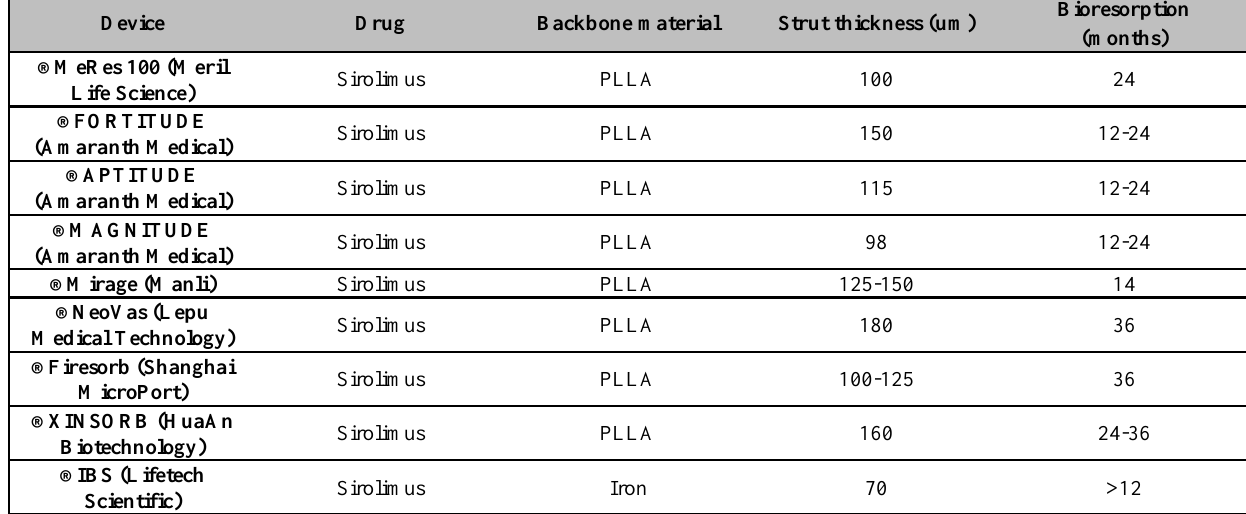
Table 3: Design characteristics of current bioresorbable scaffold technologies